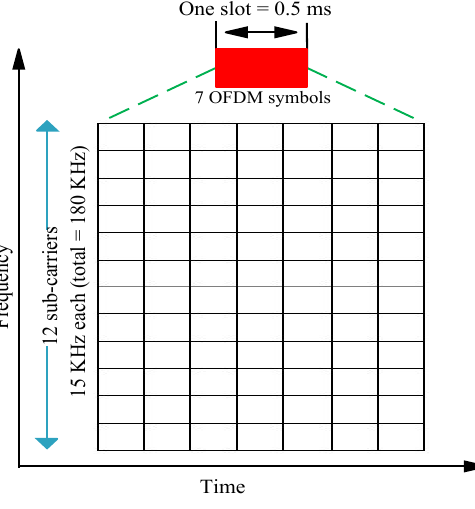
Figure 3. A Resource Block